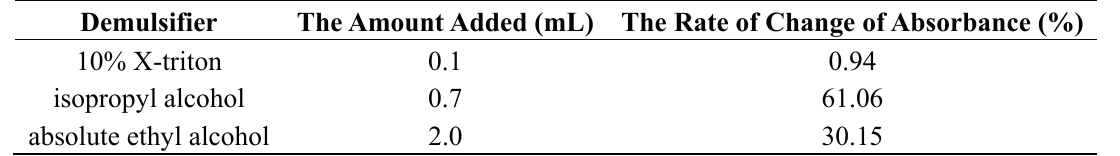
Table 1. Screening results of the